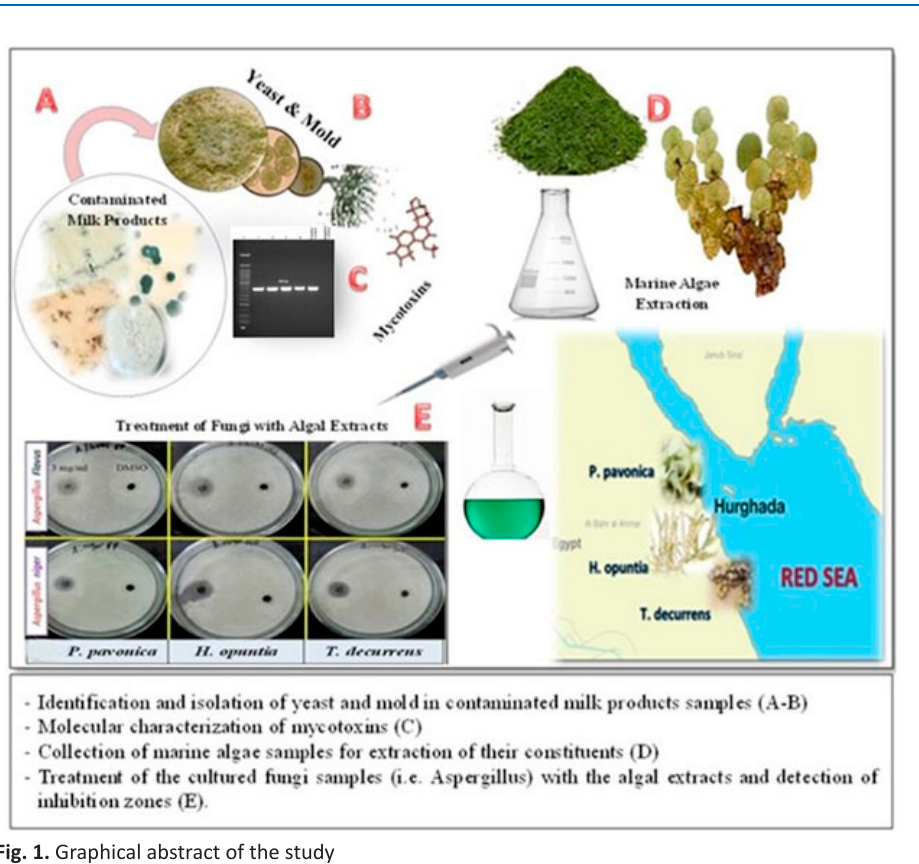
Fig. 1. Graphical abstract of the Table 3. Percent of contamination of yeast isolates in different dairy products samples (n = 20) Isolates of Yeast